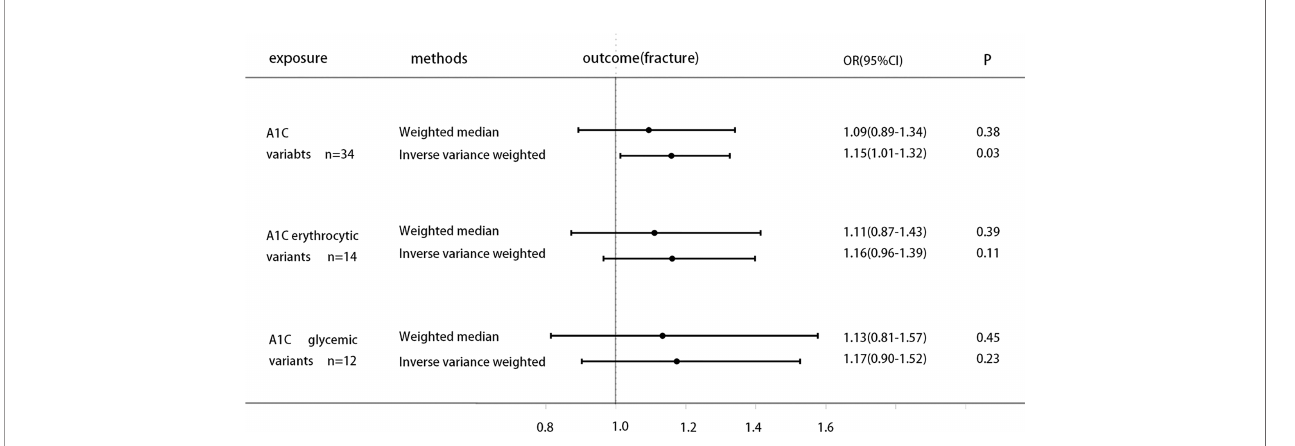
FIGURE 2 | Causal effect on Bone fracture in UKBB of increased A1C instrumented by all A1C-associated genetic variants, glycemic-only A1C variants, and erythrocytic-only A1C variants. MR analysis were performed by the IVW and WM methods. Effect estimates are OR of Bone fracture per %-unit increase in